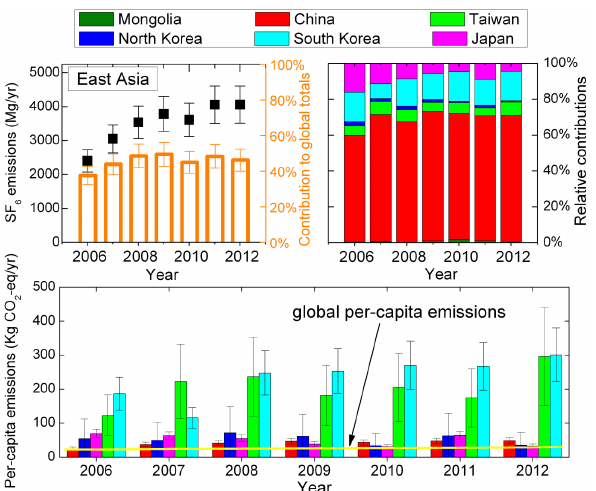
Fig. 7. Global perspective of SF 6 emissions of East Asian countries. The upper left panel shows absolute (black symbols and left Y axis) and relative contributions (orange symbols and right Y axis) of emissions in East Asia to the global totals. The upper right panel shows relative contributions of emissions from each country within East Asia. The lower panel shows per-capita emissions for each country, with the yellow line indicating the global average.